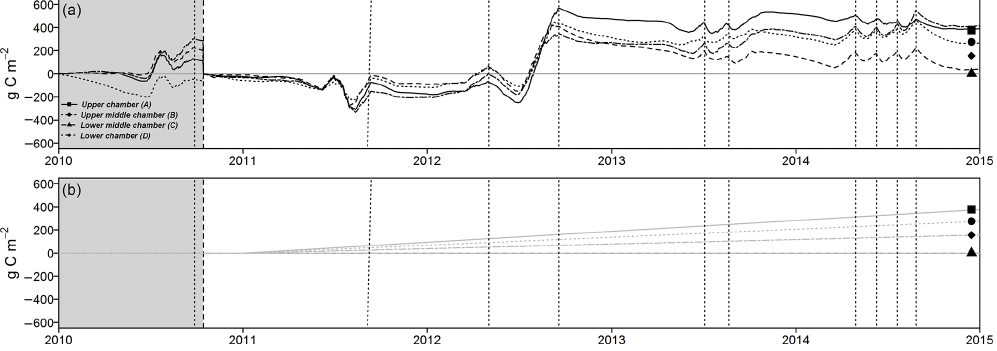
Figure 5. Temporal and spatial dynamics in cumulative NECB and (cid:49) SOC throughout the study period based on (a) the C budget method (measured–modeled, black lines) and (b) the soil resampling method (linear interpolation, gray lines), respectively. The gray shaded area represents the period prior to soil manipulation. The dashed vertical line indicates the soil manipulation. Dotted lines represent harvest events. Temporal dynamics in NECB revealed by the C budget method allow for the identification of periods that are most important for changes in SOC. Major spatial deviation occurred during the maximum plant growth period (May to September). The proportion (%) of these periods with respect to the standard deviation of estimated annual NECB accounted for up to 79%.